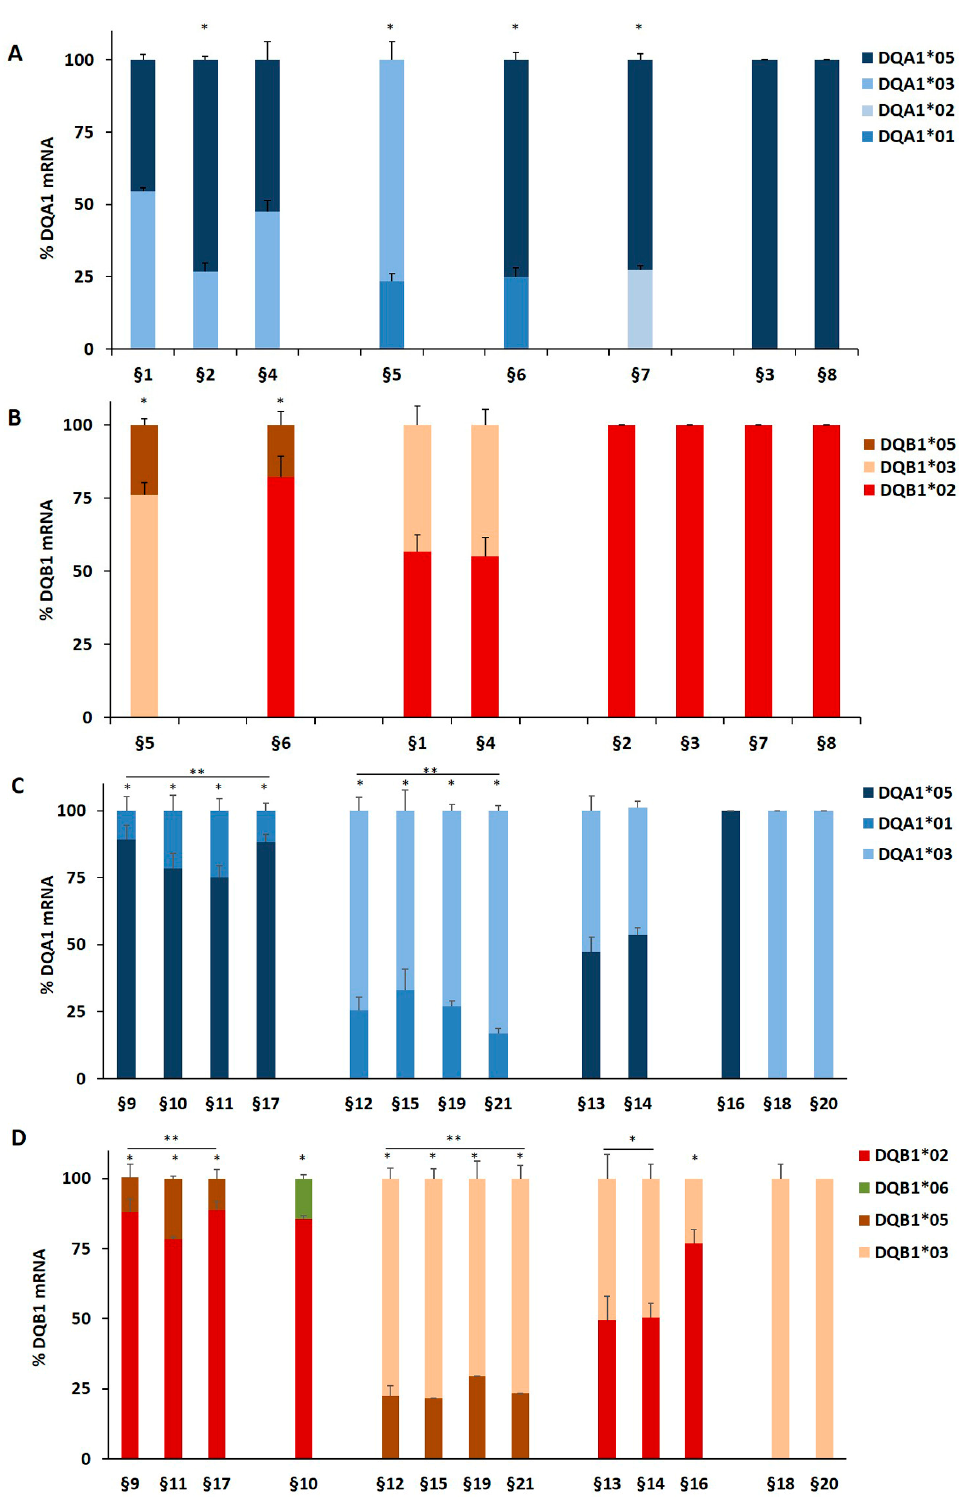
Figure 1. Expression of DQB1 and DQA1 genes. The gene expression is showed as percentages of the total DQA1 and DQB1 transcripts for each APC. Panel A and C show the expression of DQA1 alleles in B-LCL and PBMC, respectively; panel B and D show the expression of DQB1 alleles in B-LCL and PBMC, respectively. The APC are grouped by their genotypes; the significance, among the expression values of two alleles, was calculated for each patient and for the group with at least two samples (* p < 0.05, ** p < 0.005). Table 3. DQA1 and DQB1 mRNA fold change in different APC.